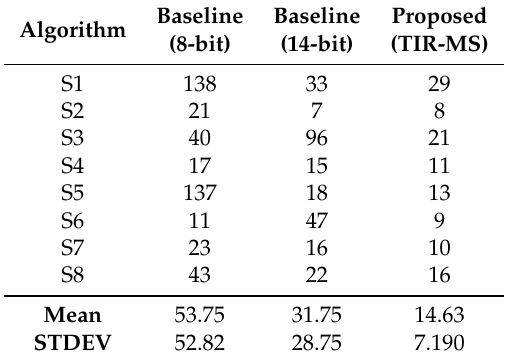
Table 4. Comparison of tracking accuracy: central difference.